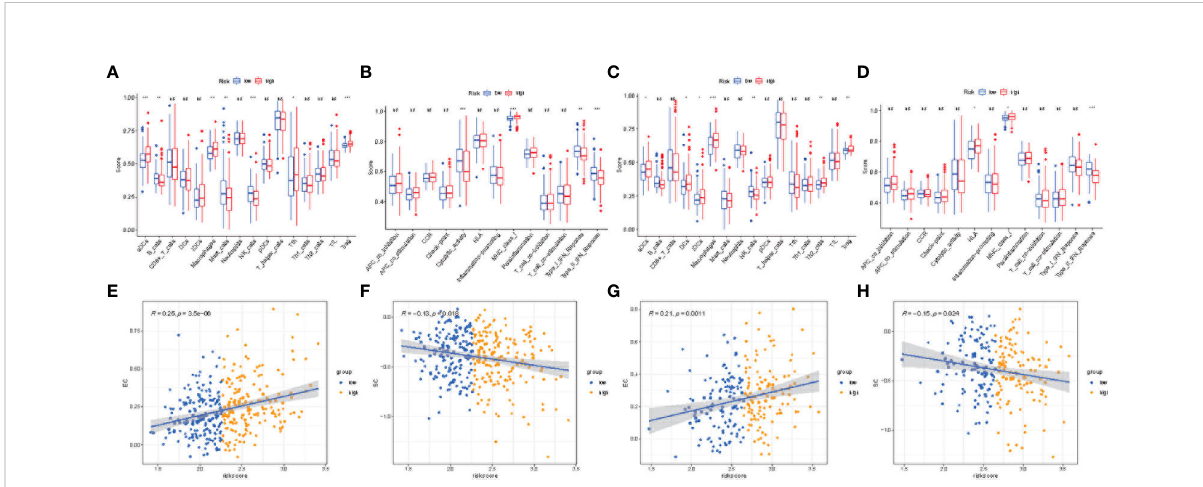
FIGURE 8 Immune microenvironment and immunophenoscore analyses. Box plots showing immune cell in fi ltration fraction and immune function activity in TCGA (A, B) and ICGC (C, D) cohorts. Correlation plot for effector cell (EC) score and risk score in TGCA (E) and ICGC (F) cohorts. Correlation plot for immunosuppressive cell (SC) score and risk score in TCGA (G) and ICGC (H) cohorts. (***p < 0.001, **p < 0.05, *p < 0.1, ns, no signi fi cance).